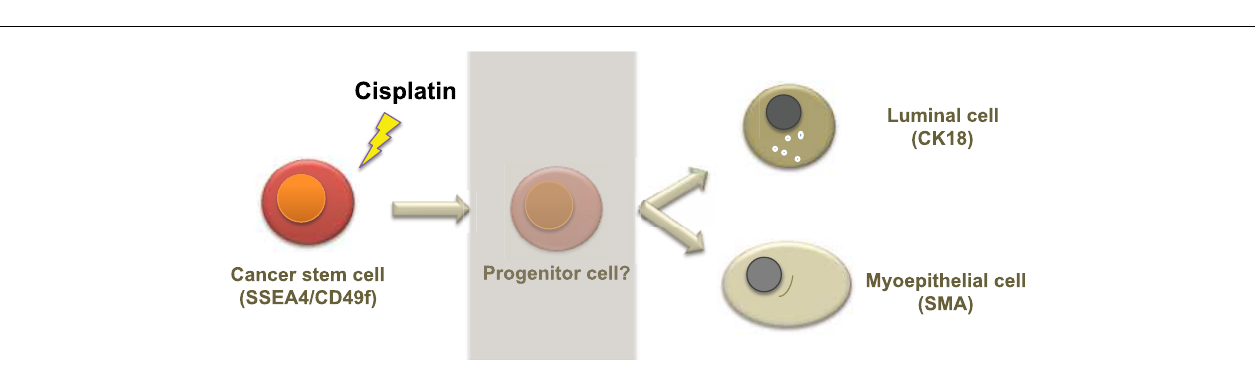
FIGURE 7 |A proposed model of cellular hierarchy in breast cancer cells and how it is influenced by cisplatin .The diagram illustrates a possible mechanism of cisplatin effects in breast cancer cells. Cancer stem cells can differentiate, potentially through progenitor steps, into a more mature